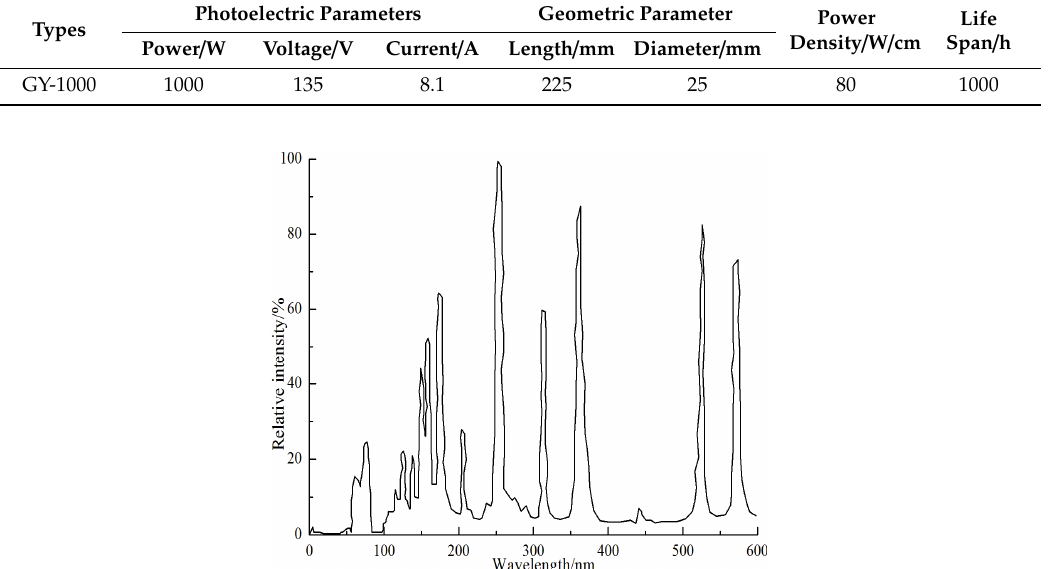
Table 4. Technical parameters of 1000 W high-pressure mercury lamp.